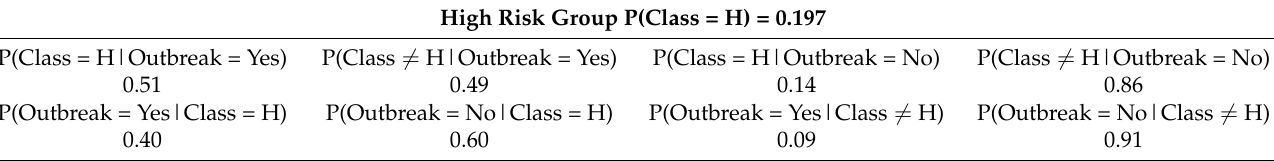
Table 2. Average classification performance in terms of P(Outbreak|Class) (i.e., probability of outbreak (Yes/No) given the assigned risk class, H) and P(Class|Outbreak) (i.e., probability of the assigned risk class given the outbreak) at the high action-thresholds (predicted risk = 0.125).